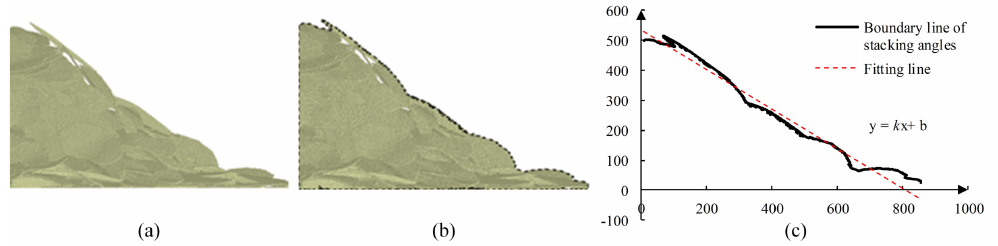
Figure 4. Tobacco strips stacking angle measurement for simulation test. ( a ) Original image of unilateral tobacco strips pile; ( b ) Edge profile image of unilateral tobacco strips pile; ( c ) Fitted plots of unilateral tobacco strips